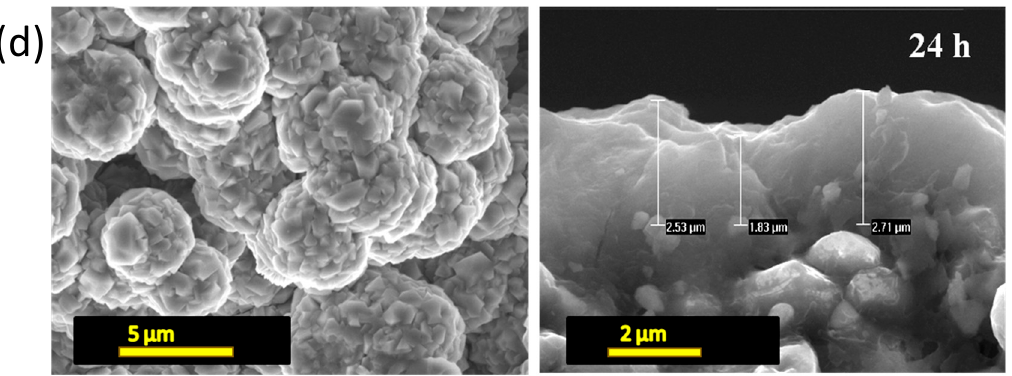
Figure 2. Scanning electron microscopy (SEM) images of FAU-type zeolite membranes prepared on Alconox ® -treated ( a , b , c ) α -Al 2 O 3 support at 75 °C for 12, 16 and 24 h. SEM images of FAU-type zeolite membranes prepared on untreated ( d ) α -Al 2 O 3 support at 75 °C for 24 h. Top view (left); cross-section of the surface (right).